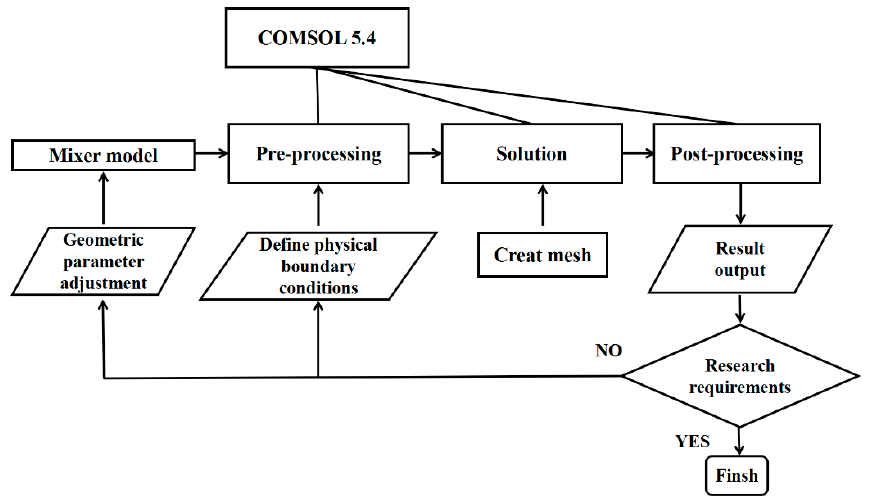
Figure 1. CFD simulation method for a cross-shaped micromixer.